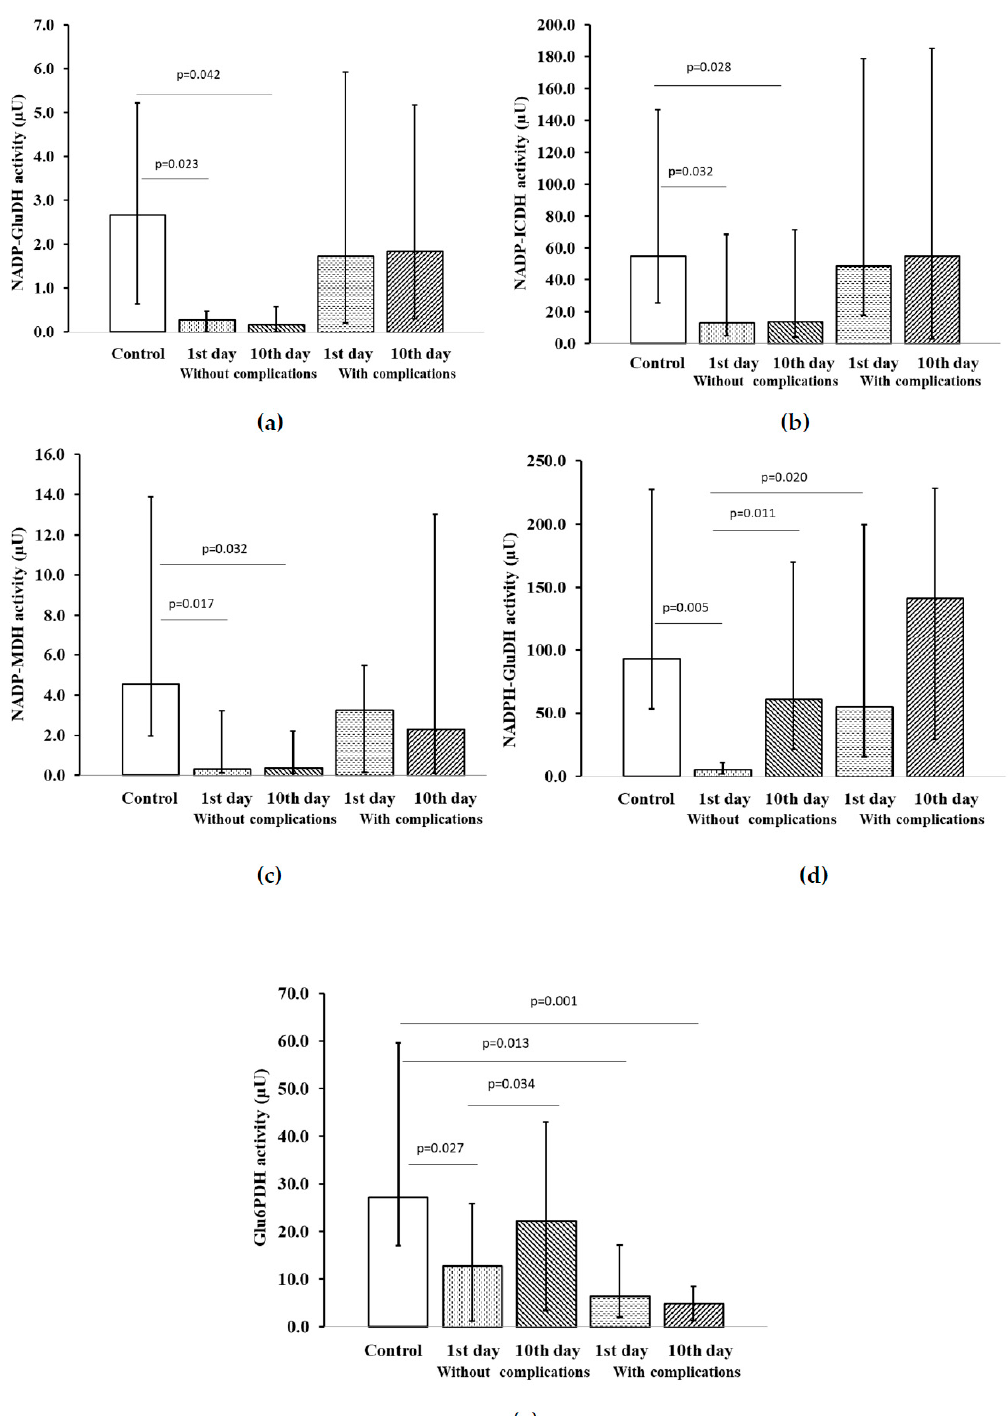
Figure 3. Activity of NADP-dependent platelet dehydrogenases in patients with ACS and ADD, depending on the development of complications: ( a ) NADP–GluDH activity; ( b ) NAD–ICDH activity; ( c ) NADP–MDH activity; ( d ) NADPH–GluDH activity; ( e ) Glu6PDH activity. Notes: Values